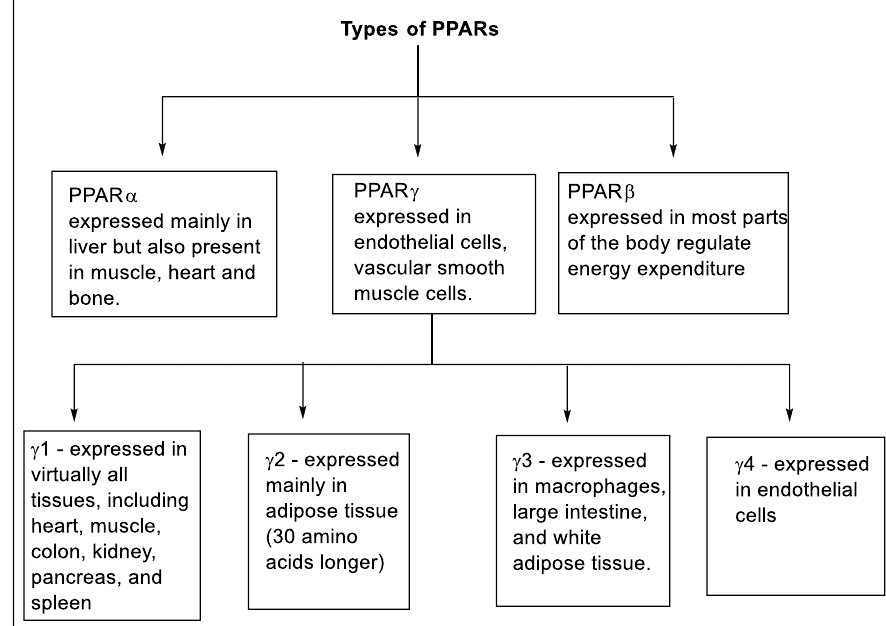
Figure 3. Types and expression of PPARs.